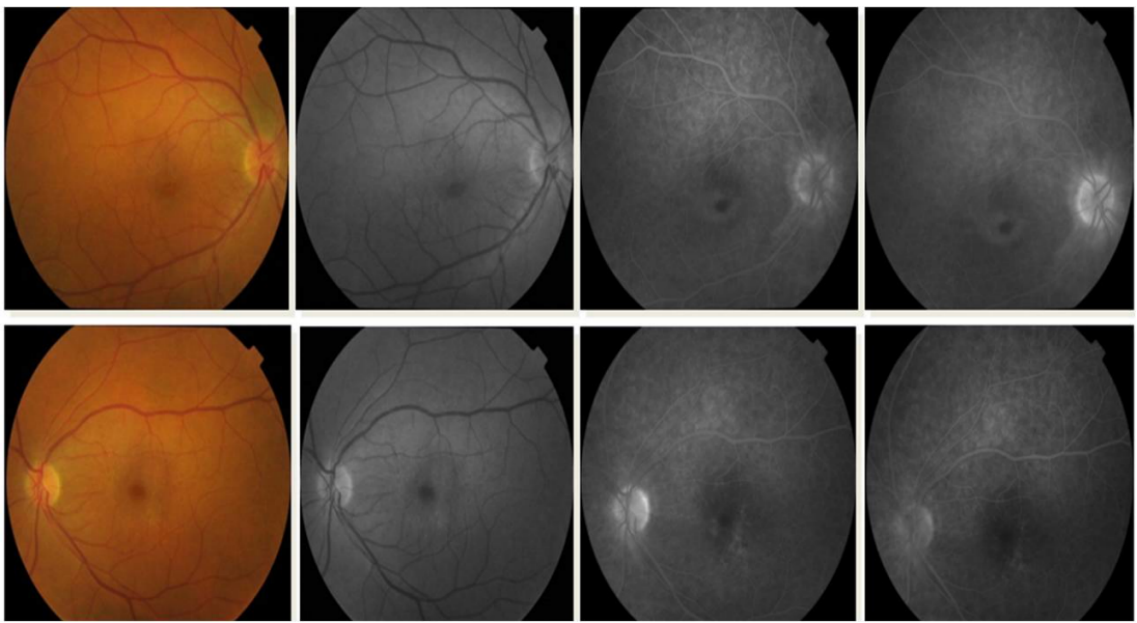
Figure 3: Retinography and angiography 2 months after the beginning of therapy (RE and LE)